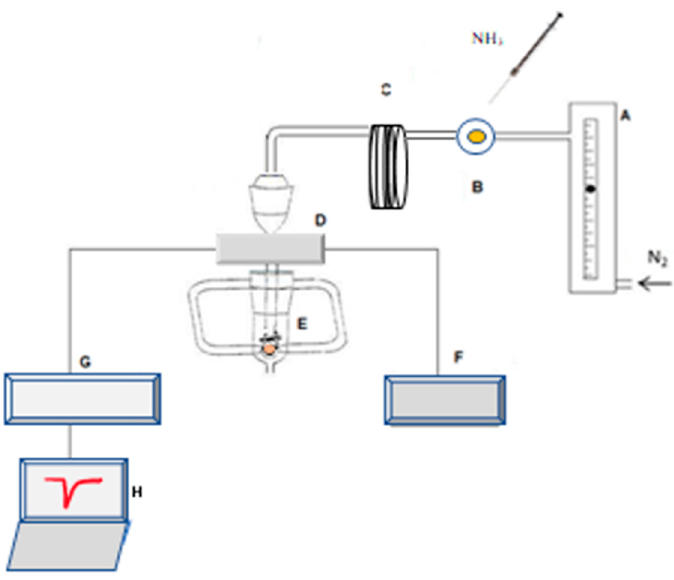
Figure 3. Experimental layout for coating selection: A—flowmeter; B—injection port; C—coil; D—oscillator; E—crystal cell; F—power source; G—frequency meter; H—personal computer for data acquisition.